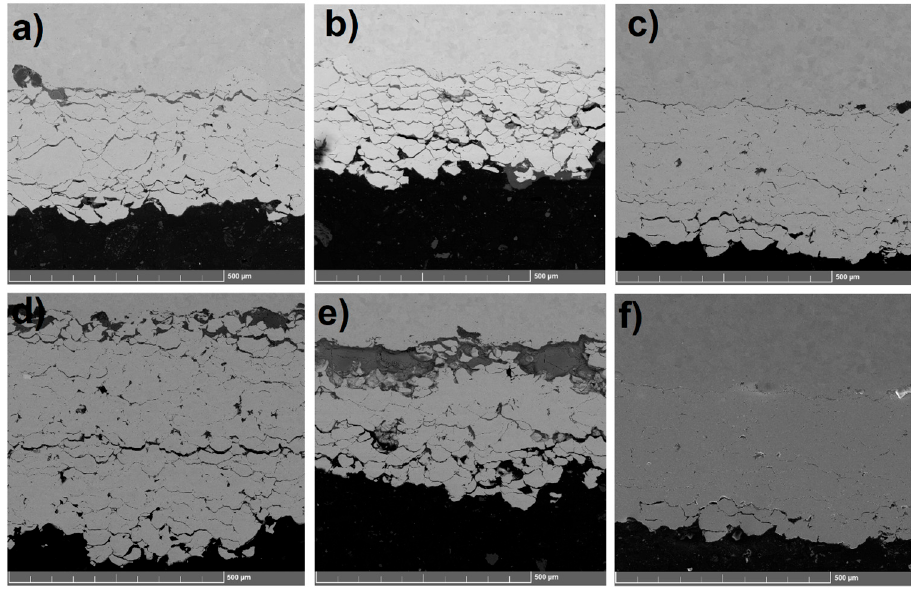
Figure 3. SEM-BSE (backscattered electron) images of all coatings: ( a ) Coating #1, ( b ) Coating #2, ( c ) Coating #3, ( d ) Coating #4, ( e ) Coating #5, ( f ) Corresponding secondary electron (SE) image of coating #3.